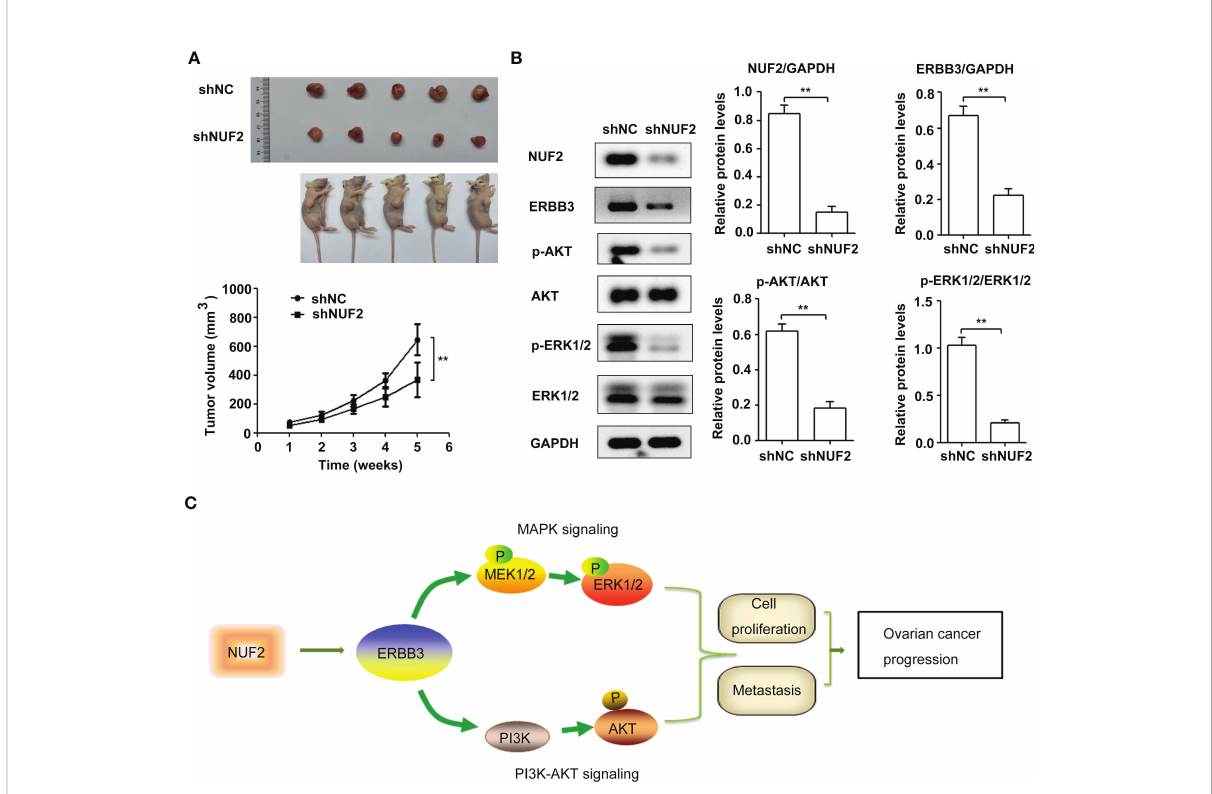
FIGURE 7 NUF2 knockdown repressed EOC tumorigenesis and inhibited ERBB3, p-AKT and p-ERK1/2 expression in vivo . (A) Representative photographs of mice and OVCAR3-shNUF2 and OVCAR3-shNC tumor samples 5 weeks after injection. Tumor volumes were measured at the indicated time points in all mice. ** P < 0.01 vs. the shNC group. (B) Western blot assay was used to determine the expression levels of ERBB3, p-AKT and p- ERK1/2 proteins in tumors. ** P < 0.01. (C) Schematic diagram summarizing the role and mechanism of NUF2 in promoting EOC progression. NUF2 promotes the PI3K-AKT and MAPK signaling axes mediated by ERBB3, thereby inducing the malignant behaviors in ovarian cancer